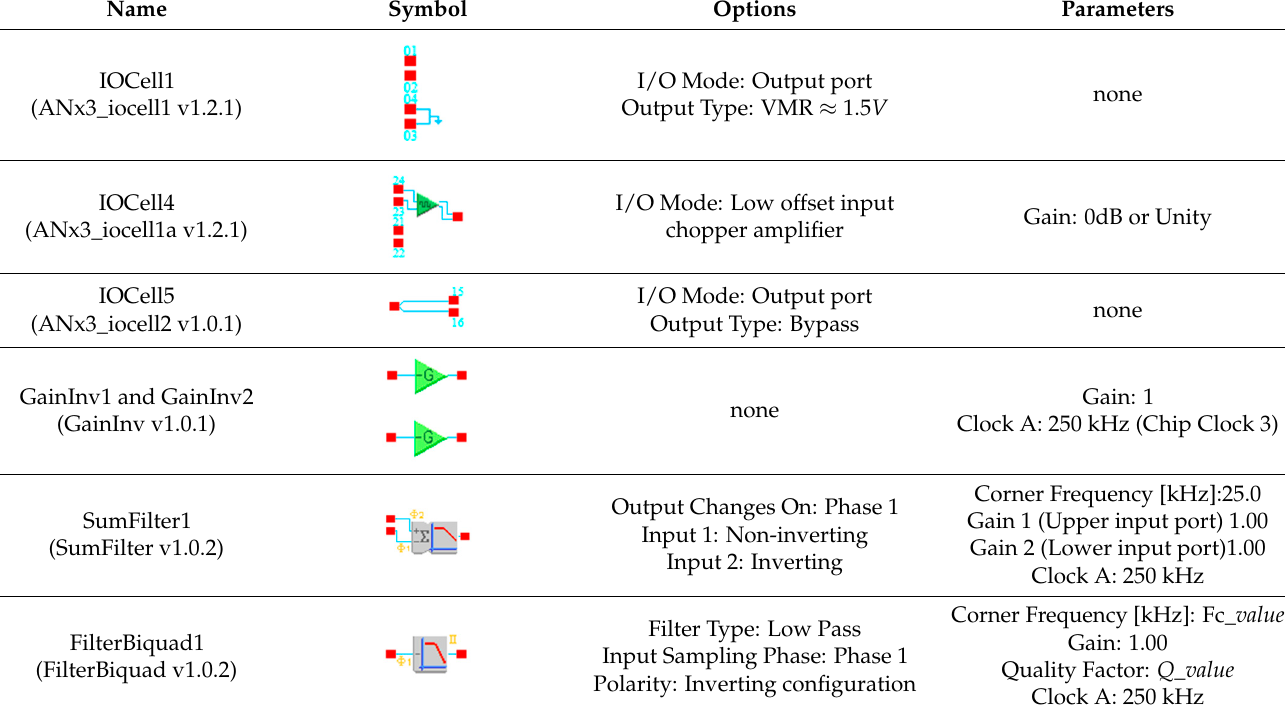
Table 1. Cams for the proposed analog circuit according to the schematic in Figure 3.